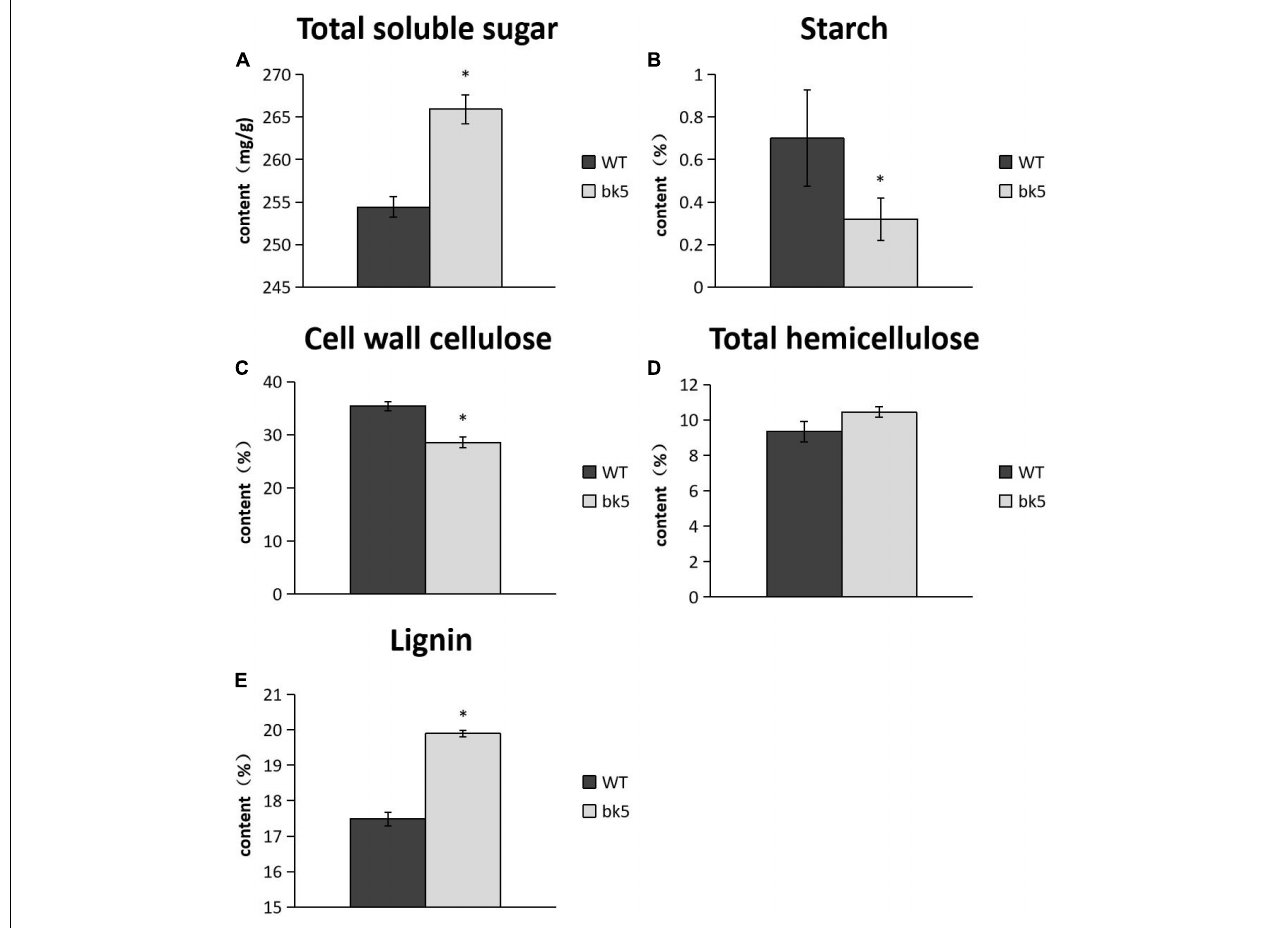
FIGURE 3 | Determination of cell wall composition. (A) Content of total soluble sugar. (B) Starch Content. (C) Cell wall cellulose. (D) Total hemicellulose content. (E) Lignin content. Biological triplicates were averaged and statistically analyzed via Student’s t -test (* p <